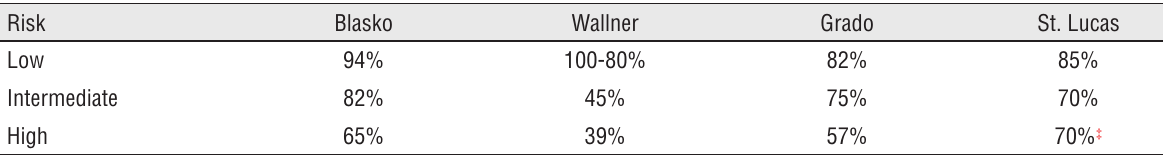
Table 5 - 5 year biochemical freedom from failure rate after brachytherapy. Results in the low risk group are similar in the different series and show a high BFFF. Blasko, Grado and our center achieved a high BFFF in the intermediate group. Relapse was high in the high risk group. As there were only 9 patients in the high risk group in our center, this data can underestimate the real relapse